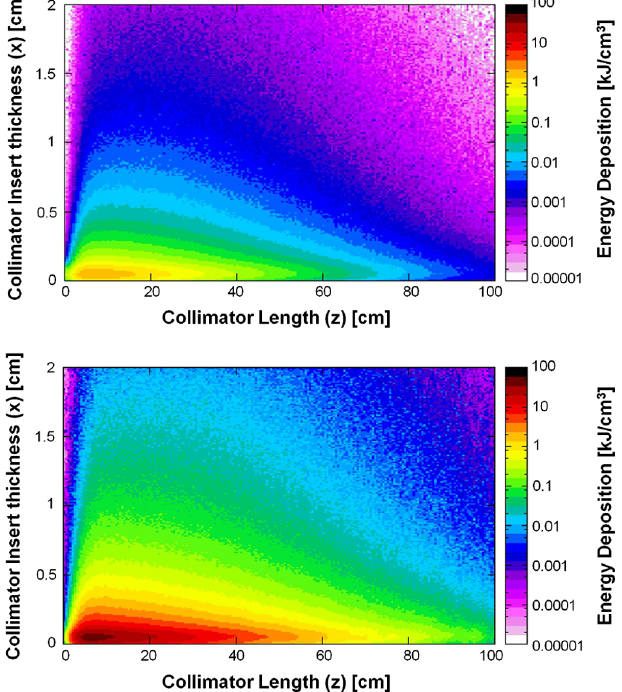
FIG. 4. Energy deposition cuts in the x-z plane at the collimator insert half-height (symmetry plane). 1 nominal bunch of lead ions ( 7 × 10 7 ions, 2759 GeV = n) (upper). 1 nominal bunch of protons ( 1 . 15 × 10 11 protons, 7 TeV) (lower).